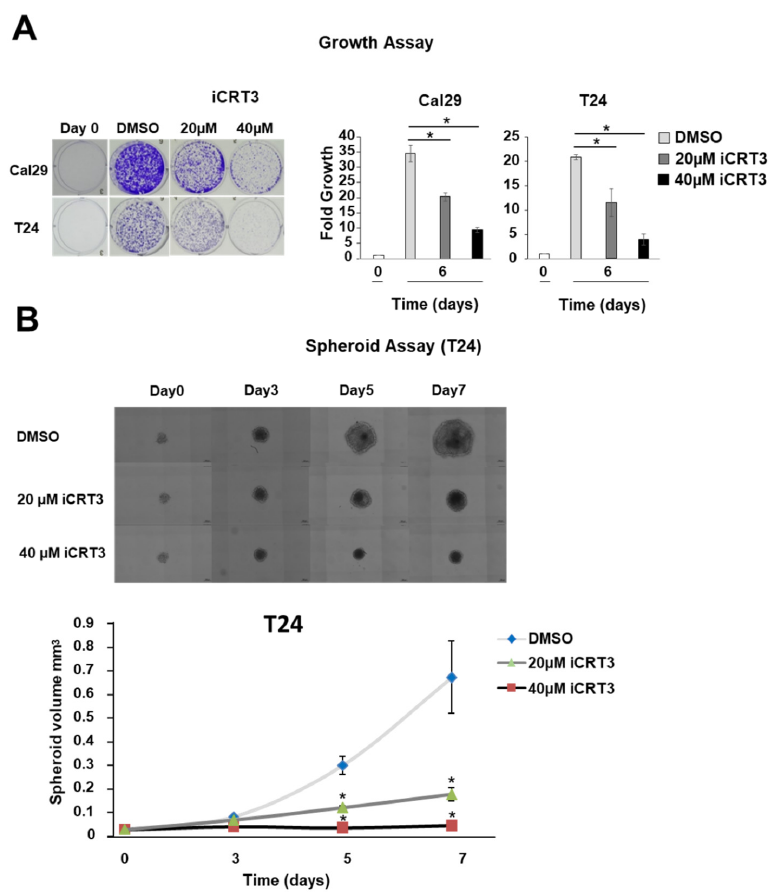
Figure 7. Proliferation and spheroid growth analysis after Wnt/ β -catenin signalling inhibition in bladder cancer cells. ( A ) Crystal violet staining of Cal29 ( n = 3) and T24 ( n = 3) cells after 8 days 0.05, Mann–Whitney U -test, n : independent biological replicates).